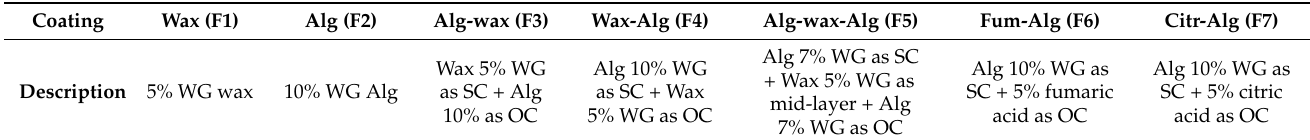
Table 1. Summary of the composition of single layer wax (F1), alginate-based (F2), and multi-layer (F3–F7)